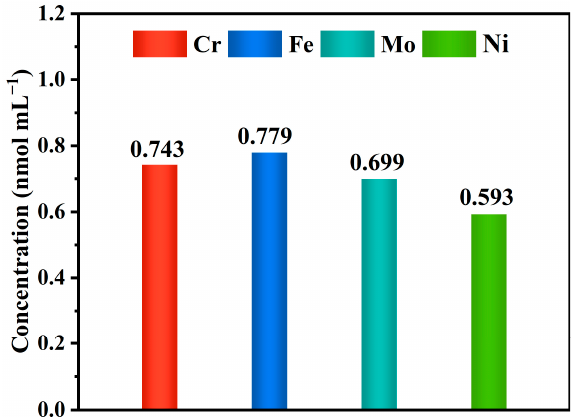
Figure 6. The concentration of metal ions from LDHs dissolved in the electrolyte.